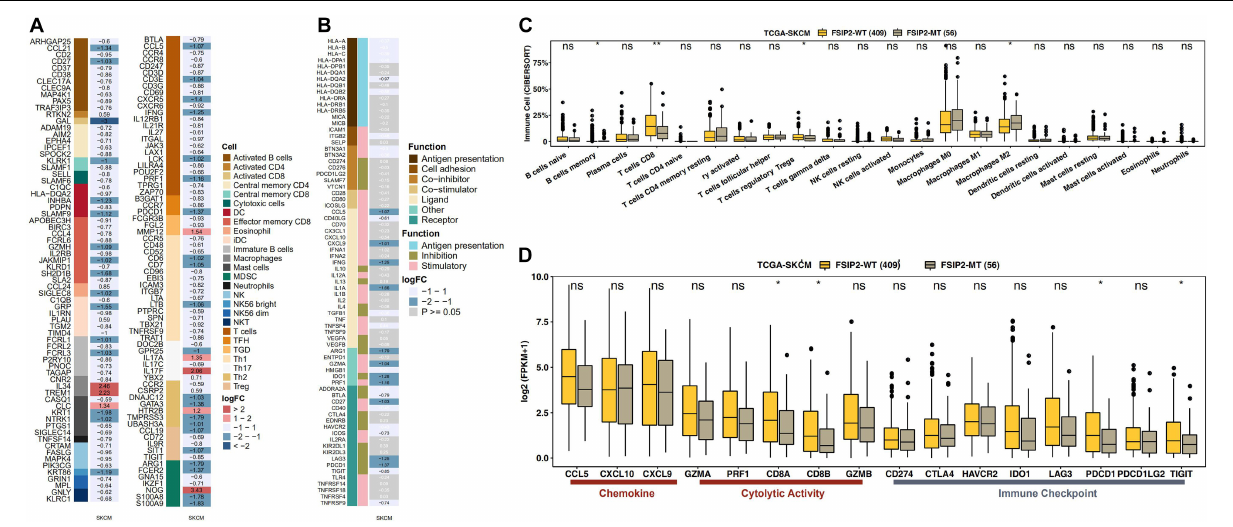
FIGURE 4 | FSIP2 mutation affects tumor immune resistance. (A) Heat map of infiltrating immune cells in the FSIP2-MT and FSIP2-WT groups in the SKCM-TCGA cohort. We marked different infiltrating immune cells with different colors. The FC cutoff was set to be greater than 1.49 or less than 0.67, and row annotation represents the immune cells to which genes belong. (B) Immune gene heat maps for the FSIP2-MT and FSIP2-WT groups in the SKCM-TCGA cohort. Similarly, the FC cutoff was selected to be greater than 1.49 or less than 0.67, and the row annotation represents the function of the gene. Genes shown in black font have FC > 1.49 or < 0.67 and p < 0.05; genes shown in white font were not significantly different between the two groups. (C) The TCGA-SKCM cohort was grouped according to the FSIP2 mutation status, with yellow for the FSIP2-WT group and gray for the FSIP2-MT group. The Mann-Whitney U test was used to analyze differences in the infiltration levels of 22 types of immune cells between the two groups, and the results with significant differences are marked with *. (D) Immune-related genes were analyzed according to functional classification (chemokine, cytolytic activity, and immune checkpoint) using the Mann-Whitney U test. The results with significant differences are marked with * (* p < 0.05; ** p < 0.01).